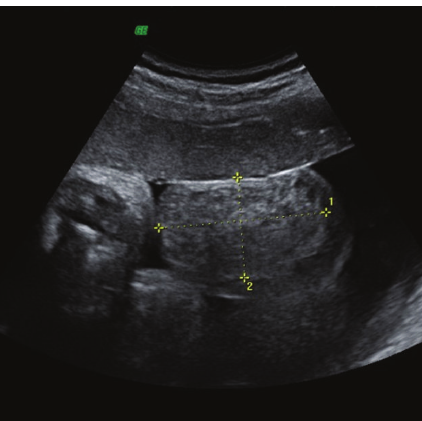
Figure 4: The presence of right inguinal scrotal hernia at